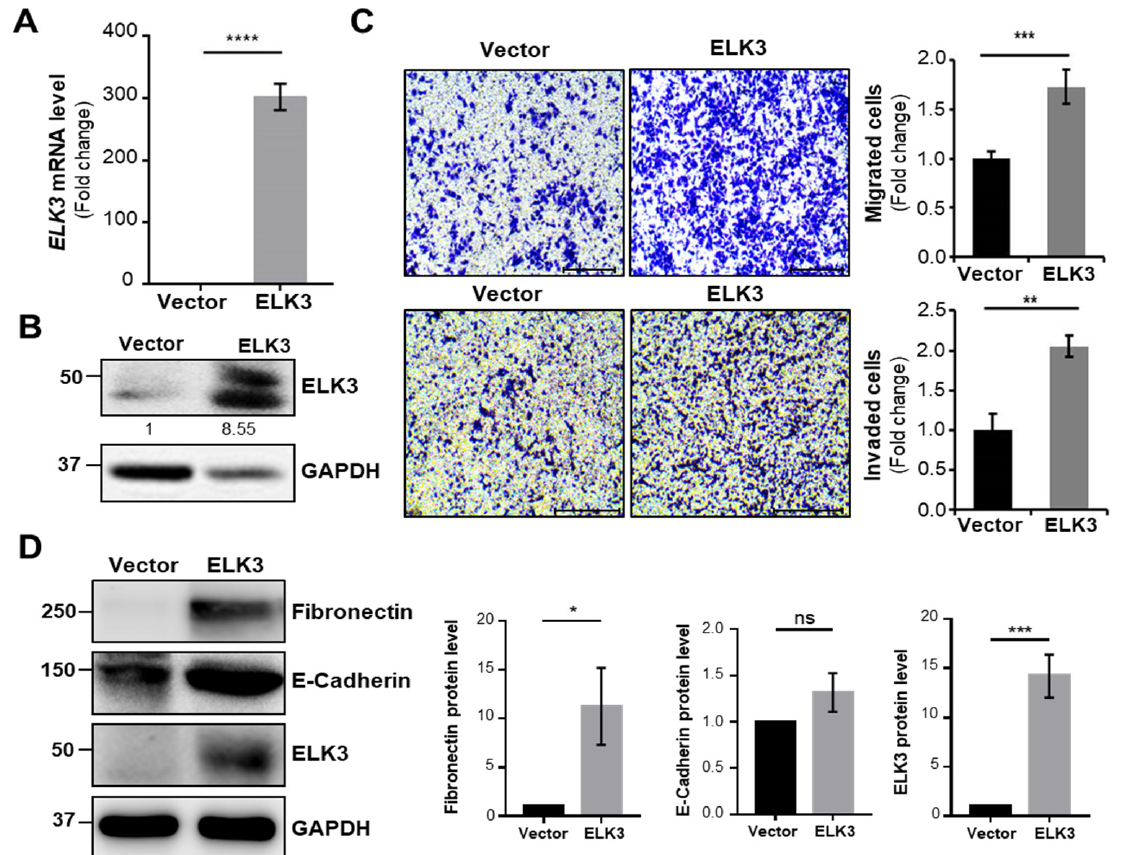
Figure 2. ELK3 increases the migration and invasion of SNU484 cell line in E-cadherin independent manner. ( A ) ELK3 mRNA levels in SNU484 cells transfected with control vector and pLenti-cMyc- DDK- ELK3 plasmid. Error bars represent the standard deviation; **** p < 0.0001 (student’s t -test). ( B ) ELK3 protein levels in SNU484 cells transfected with control vector and pLenti-cMyc-DDK- ELK3 plasmid. The values indicate the signal intensities of ELK3 relative to GAPDH. ( C ) Representative images showing cell migration (top two panels) and cell invasion (bottom two panels) of SNU484 cells transfected with control vector and pLenti-cMyc-DDK- ELK3 plasmid. Scale bar, 200 µ m. Bar graphs indicate the number of migrated cells and invaded cells. Error bars represent the standard deviation; ** p < 0.01 and *** p < 0.001 (student’s t -test). ( D ) Epithelial marker (E-cadherin), mesen- chymal marker (Fibronectin), and ELK3 protein expression in SNU484 cells transfected with control vector and ELK3 . Bar graphs indicate the quantified levels of each protein, in relative scales. Error bars represent the standard deviation; * p < 0.05 and *** p < 0.001 (student’s t -test). ELK3, ETS tran- scription factor ELK3; Vector, control vector.